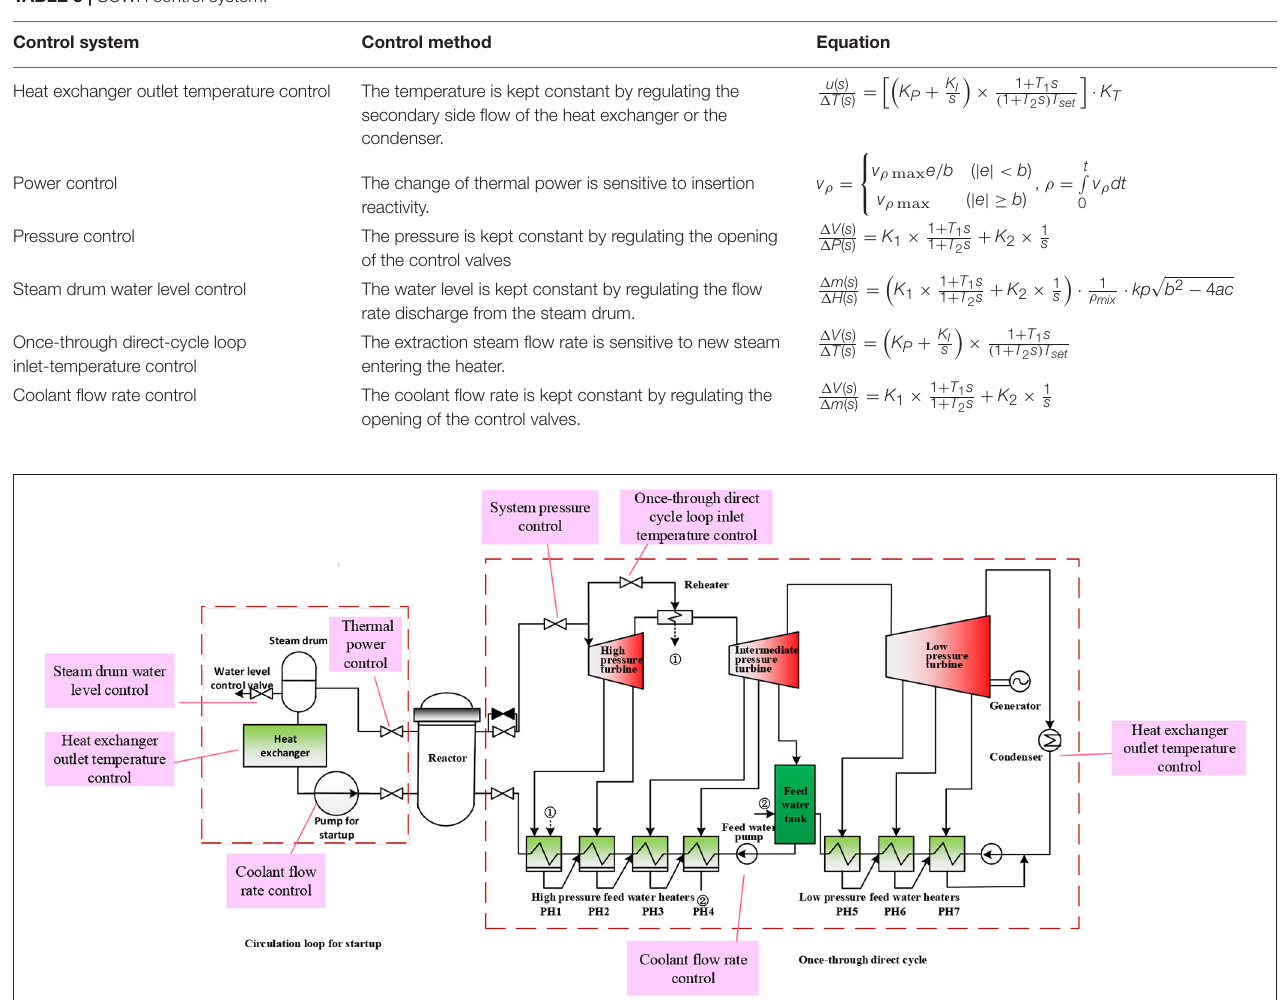
FIGURE 5 | Control system strategies for SCWR sliding pressure startups with circulation loop.